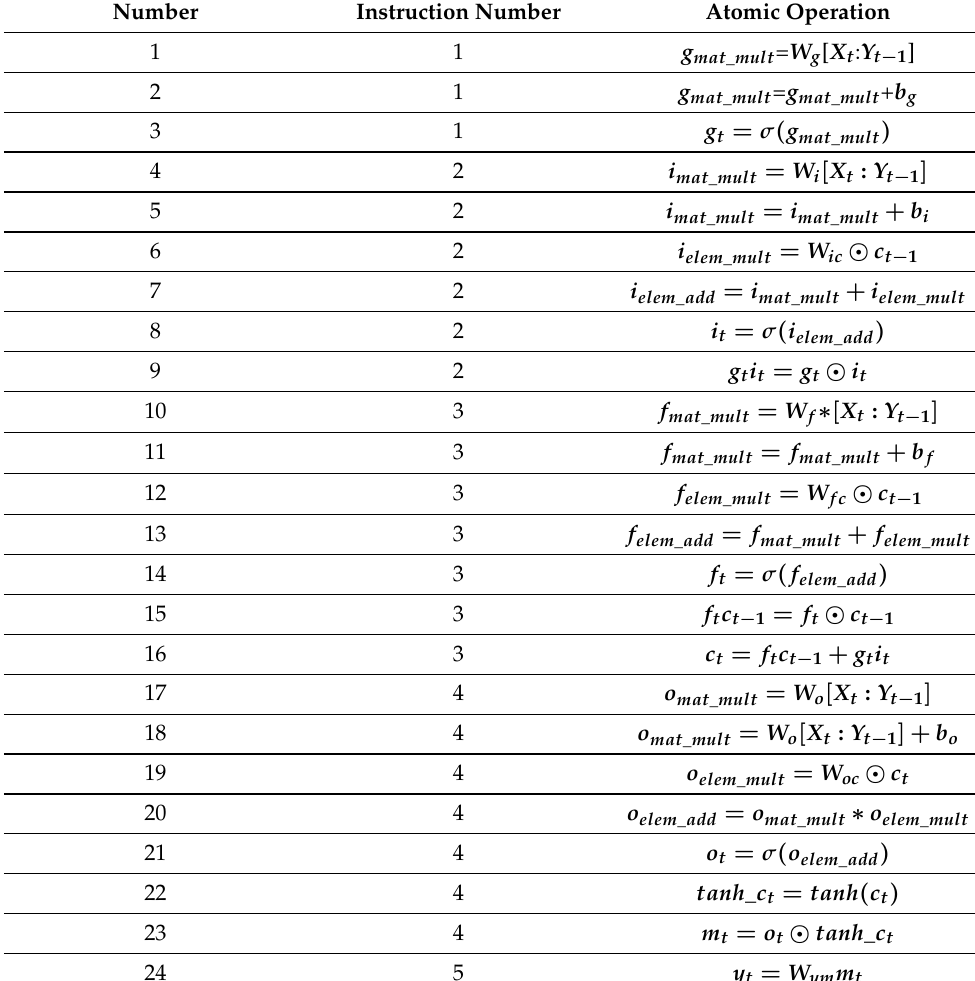
Table 3. Splitting the LSTM into a sequence of instructions.